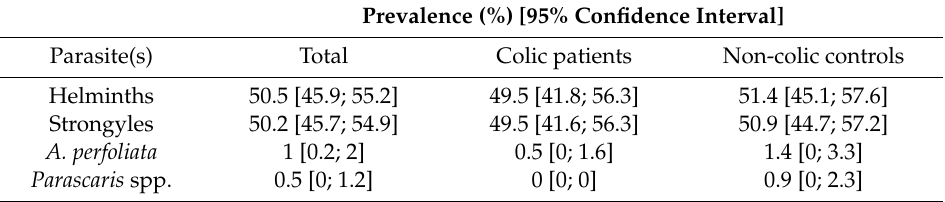
Table 2. Prevalences of eggs from gastro-intestinal helminths in horses which did not receive anthelmintic treatment during the previous eight weeks ( n =